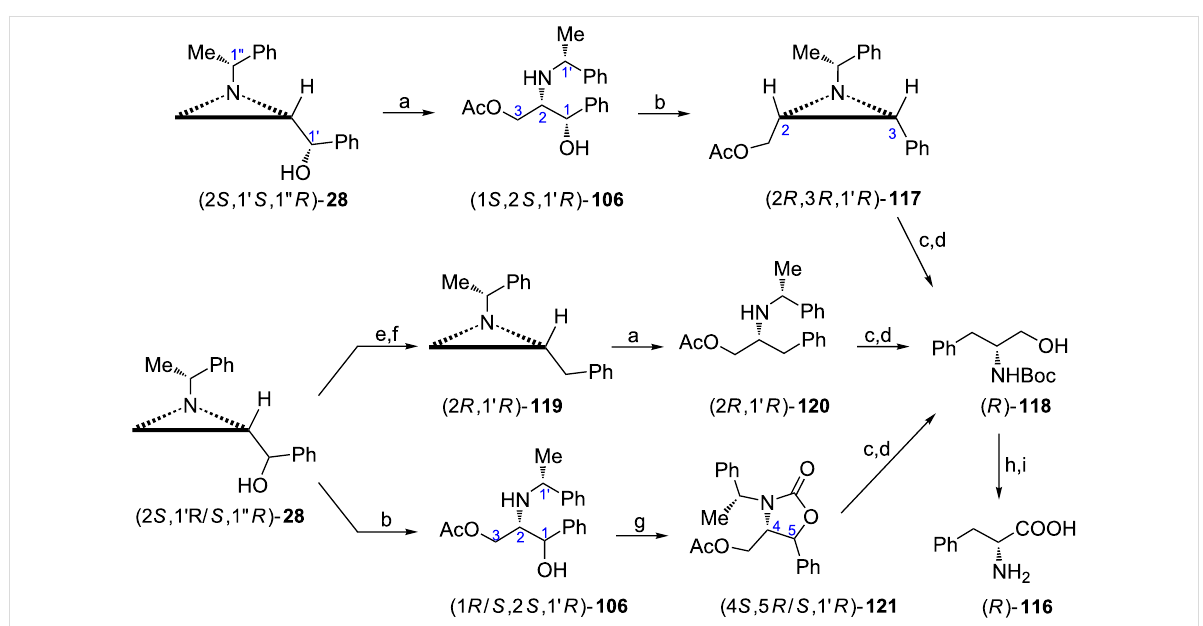
Scheme 30: Syntheses of ᴅ -phenylalanine ( R )- 116 . Reagents and conditions: a) AcOH, CH 2 Cl 2 , reflux, 4 h; b) MsCl, TEA, CH 2 Cl 2 , − 78 °C to rt, 6 h; c) H 2 , Pd(OH) 2 , Boc 2 O, MeOH, rt, 7 h; d) KOH, EtOH, rt, 10 min; e) MsCl, TEA, CH 2 Cl 2 , 0 °C, 2 h; f) LiAlH 4 , ether, rt, 4 h; g) CDI, CH 2 Cl 2 , rt, 24 h; h)